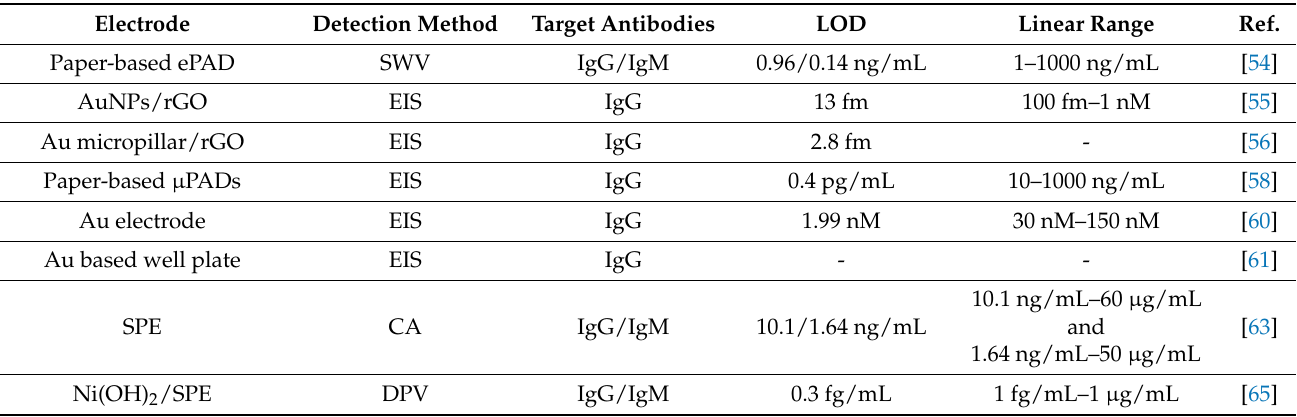
Table 2. Analytical performance of recently developed electrochemical biosensors for the detection of SARS-CoV-2